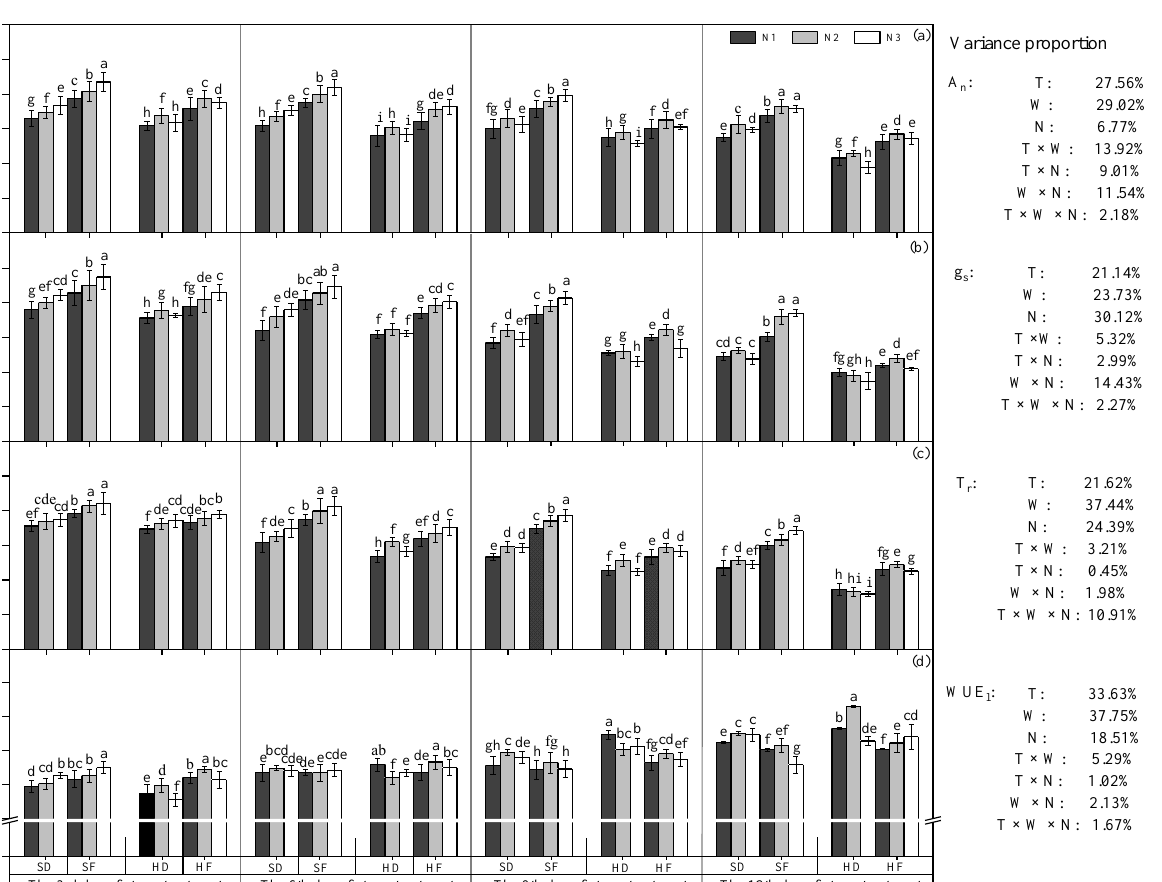
HD HFHD HFHD HF